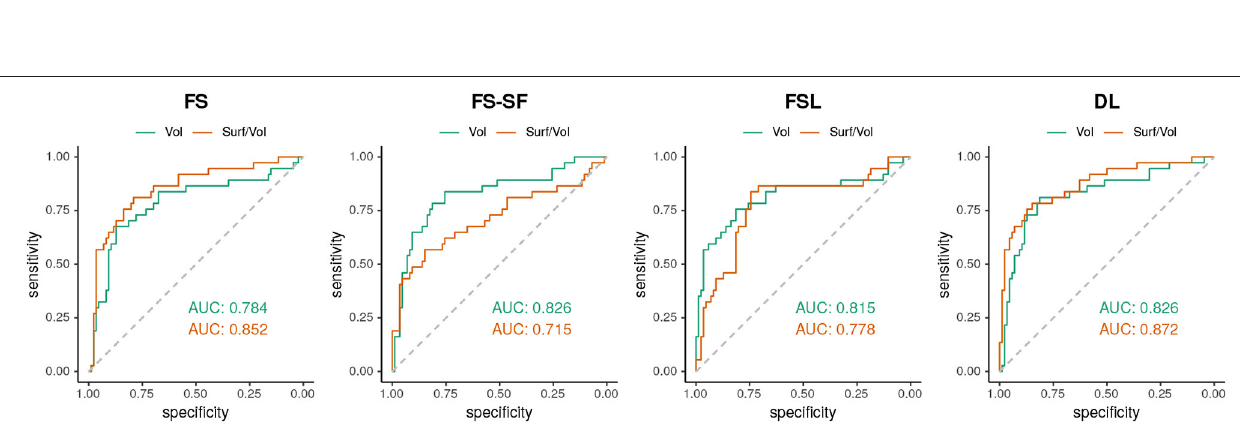
Frontiers in Neurology |